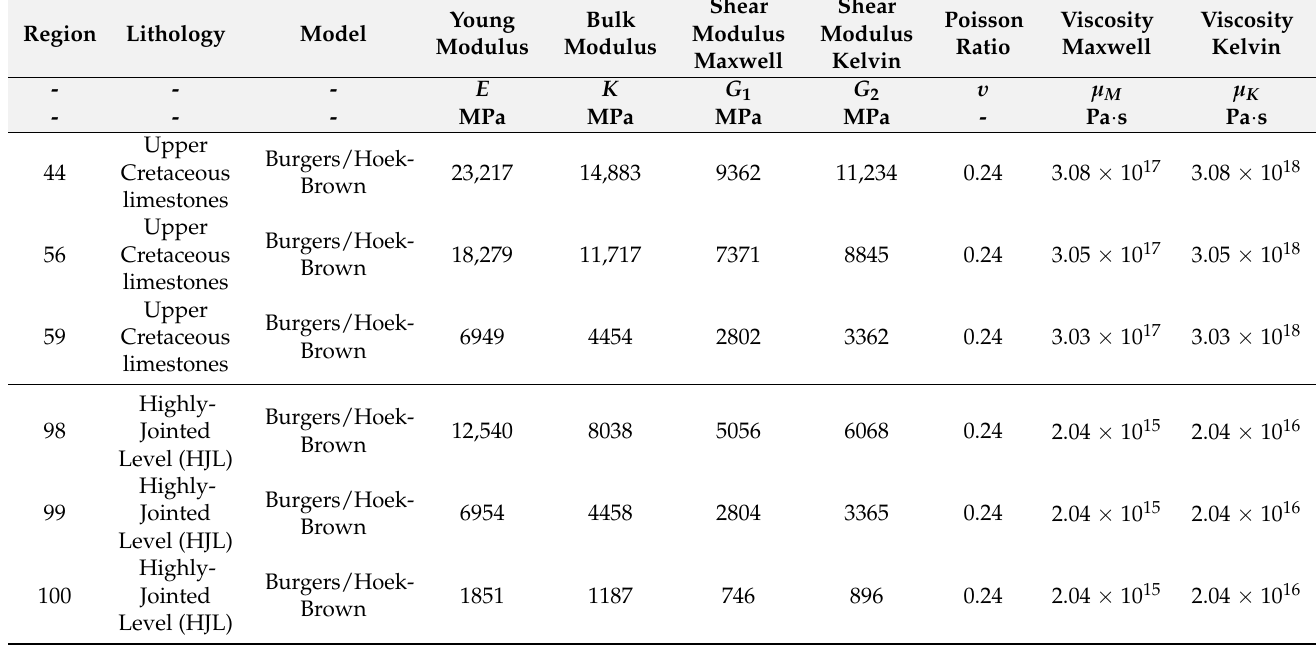
Table 4. Synthesis of elastic and viscous parameters used for the rock mass. In this table, only the characteristics of the regions directly involved in DSGSD are reported. For location of different regions, please refer to Figure 7.